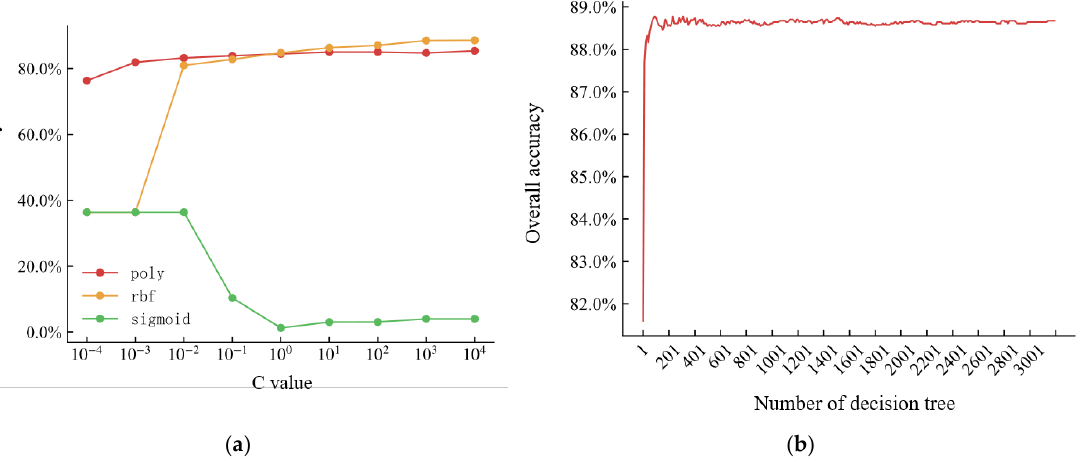
Figure 13. Comparison of efficiency using different kernel functions of SVM ( a ) and a different number of trees in random forest ( b ).